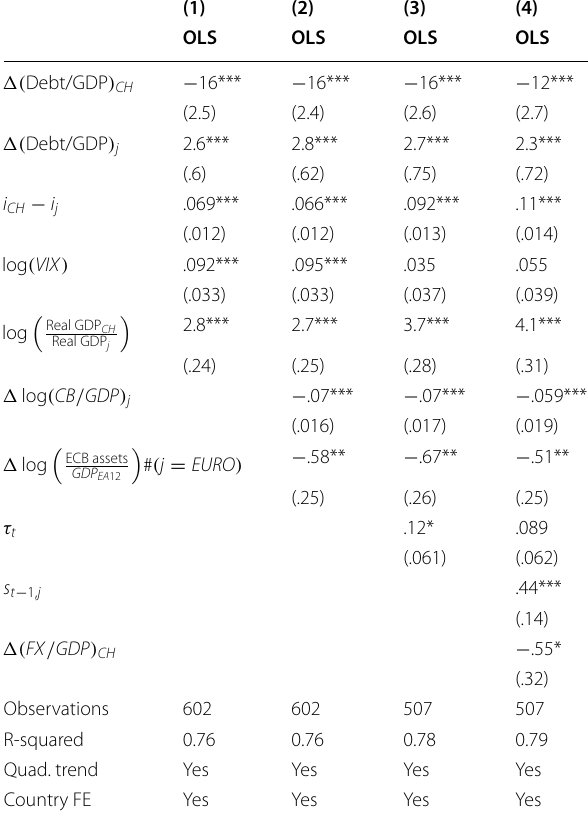
Table 4 The Role of Central Banks’ Sovereign Debt Purchases and the Exchange